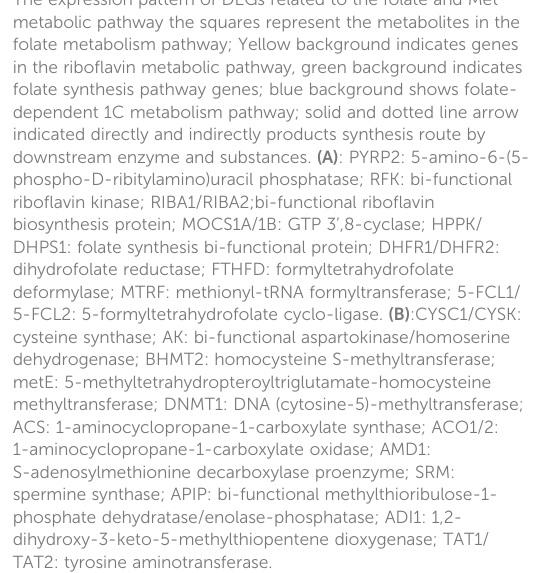
FIGURE 5 The distribution characteristic of miRNAs in the panicle of foxtail millet following SA treatment (A) the sequence length distribution of pre-miRNA; (B) the sequence length distribution of mature-miRNA; (C) the base bias analysis of miRNA at the fi rst nucleotide position; (D) the bias analysis of each base for 21~24 nt miRNA; (E) the distribution of miRNA family members.